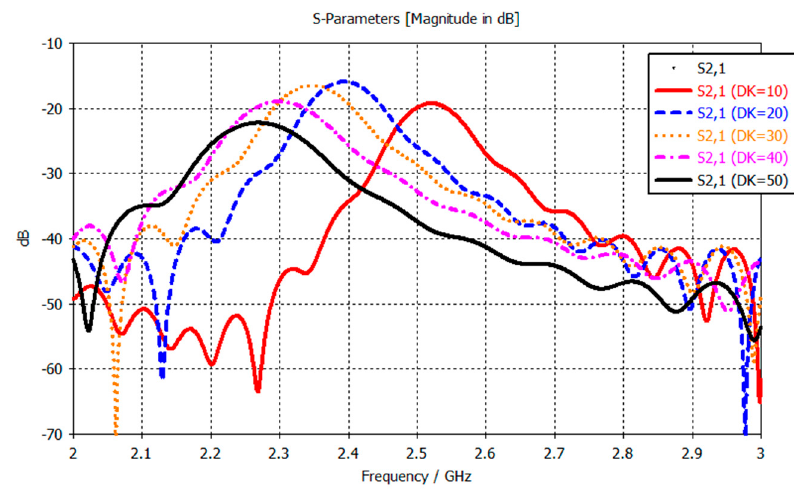
Figure 2. Frequency response for varying dielectric properties for the SRRs.